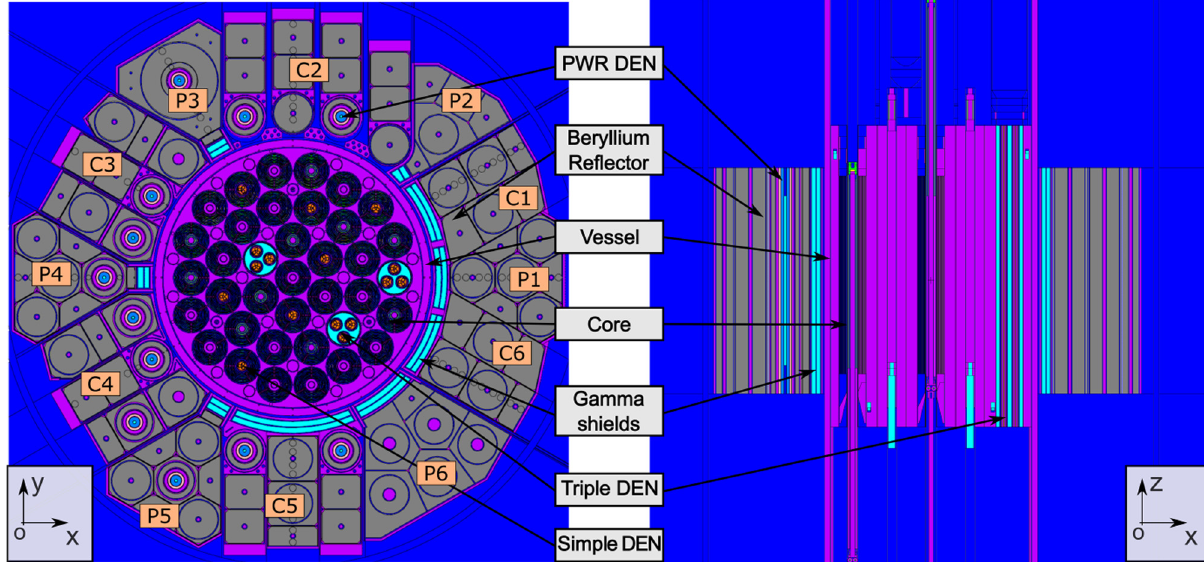
Fig. 1. JHR general description. Sectors name is given within orange boxes. Grey is for beryllium, blue for water, purple for aluminum, turquoise blue for zircaloy and orange for